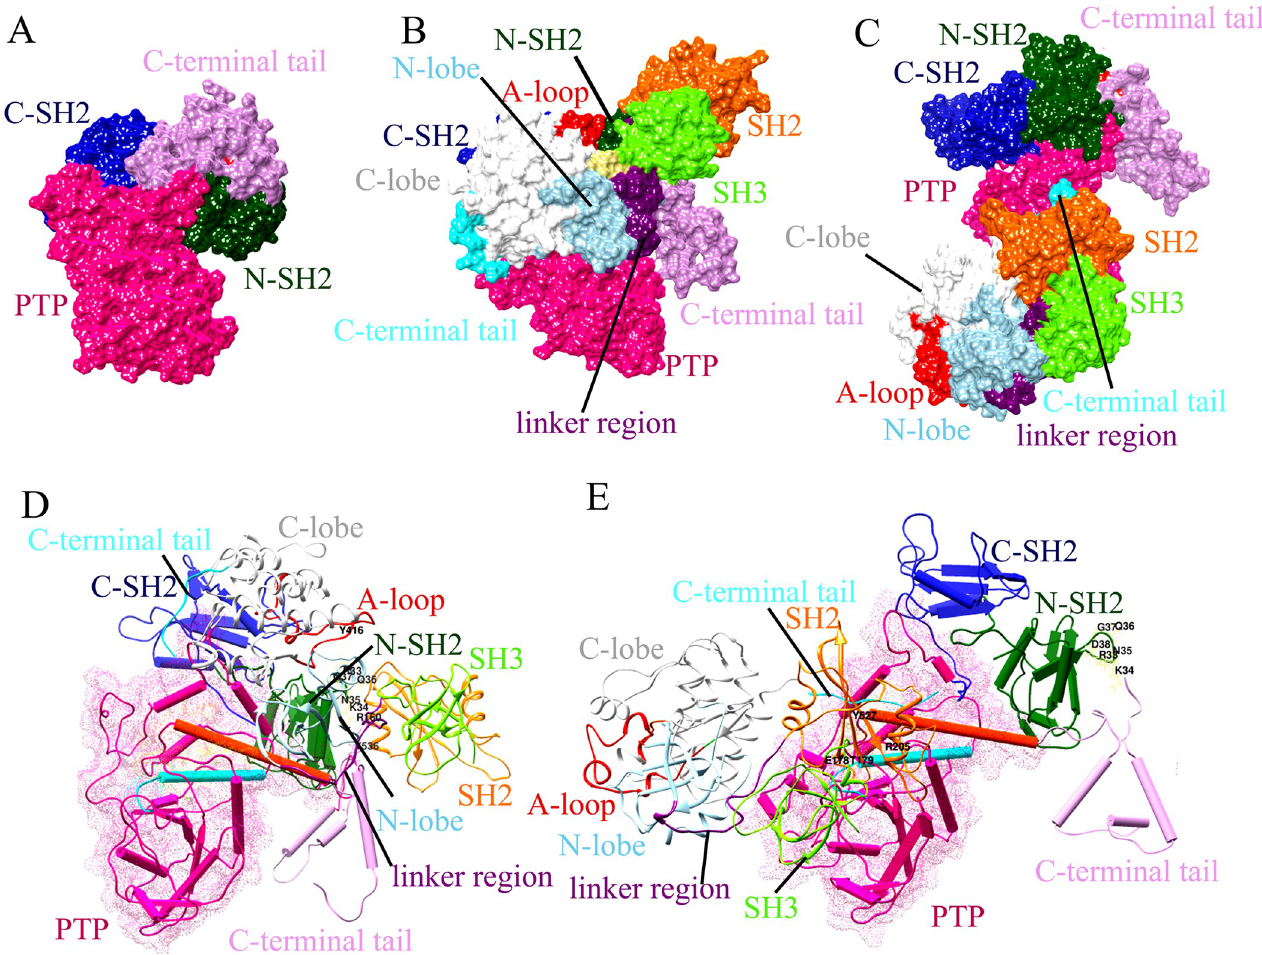
Fig 5. Surface view and the conformational switches in SHP-1 upon binding of c-Src open and c-Src close . Surface view representation of (A) SHP-1, (B) c- Src open -SHP-1 complex, and (C) c-Src close -SHP-1 complex. Conformational switches in (D) c-Src open -SHP-1 complex and (E) c-Src close -SHP-1 complex. The corresponding text indicates the color codes of individual